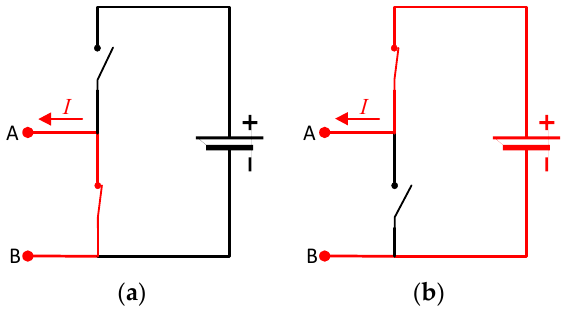
Figure 3. Schematics of the smart battery cell: ( a ) battery cell bypassed; ( b ) battery cell inserted.